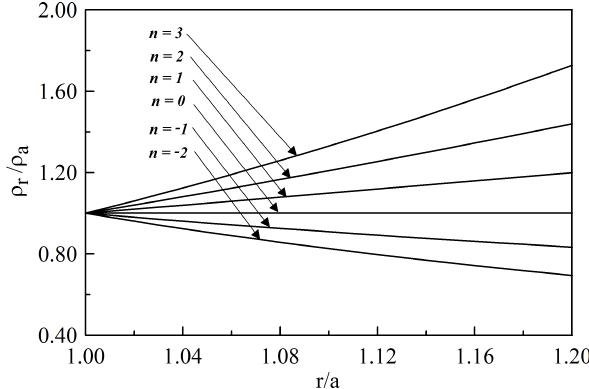
Figure 4: Radially distributed density